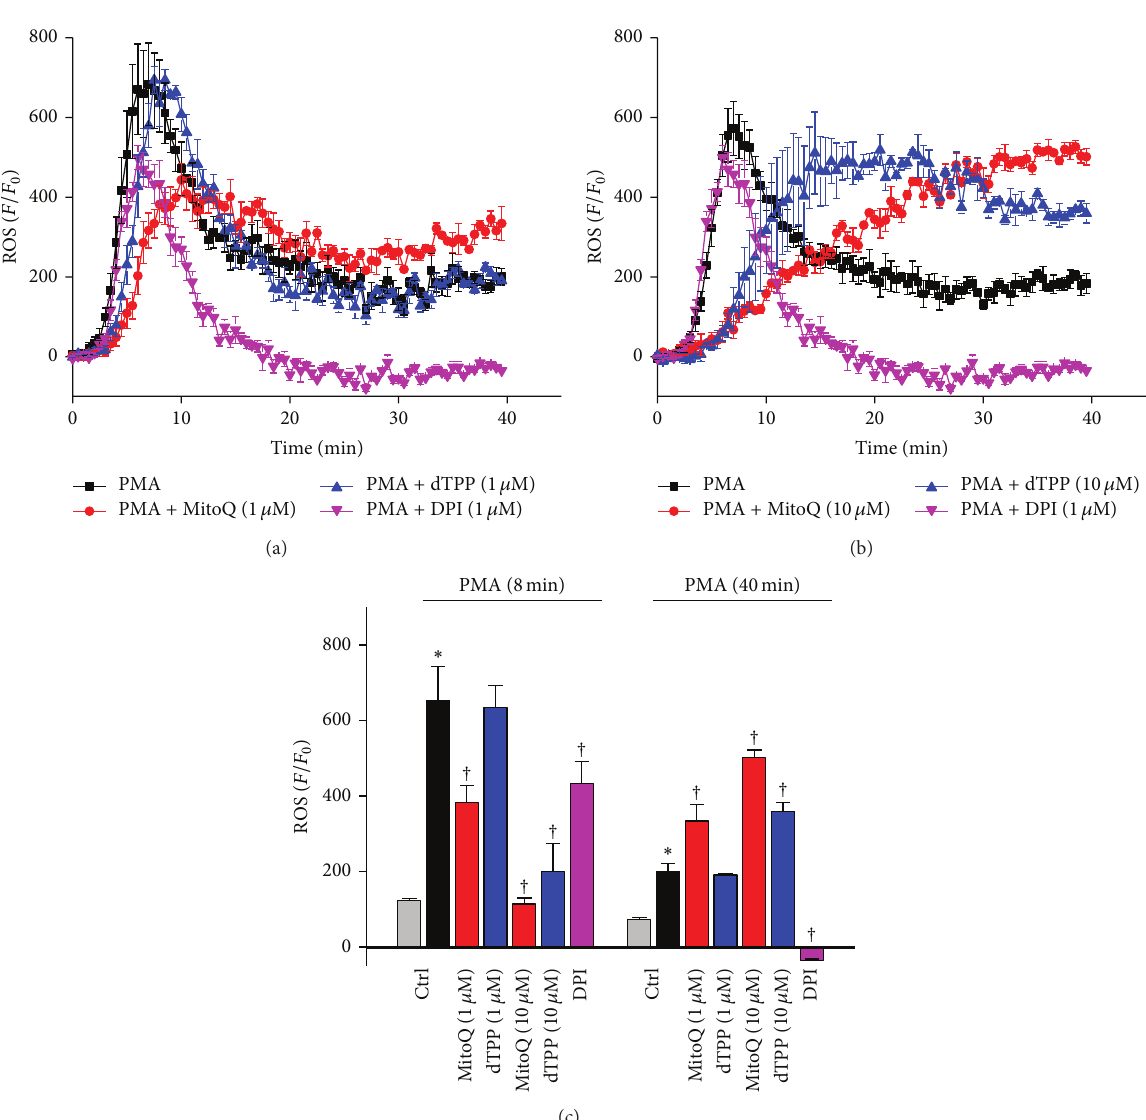
Figure 7: Effects of MitoQ on PMA-induced ROS production in isolated PMNs. (a) Effects of 1 𝜇 M MitoQ or dTPP and 1 𝜇 M DPI on ROS production induced by 50 ng/mL PMA. (b) Effects of 10 𝜇 M MitoQ or dTPP and 1 𝜇 M DPI on ROS production induced by 50 ng/mL PMA. (c) Summary bar charts for PMA-induced ROS production at 8mins (peak) and 40 mins for all experimental groups. ∗ 𝑃 < 0.05 when compared with control groups and † compared with PMA alone group. Values are the mean ± SEM ( 𝑛 ≥ 3 mice per